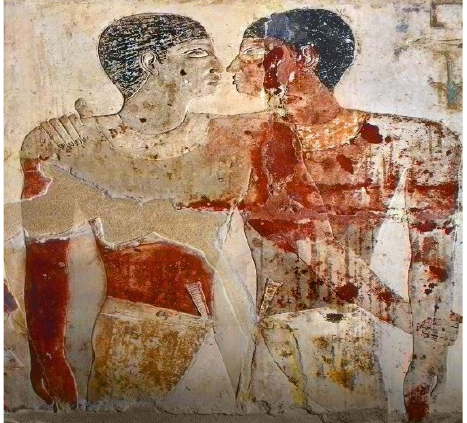
Figure 1. Dating from the Fifth Dynasty, the Nyankh-khnum and Khnum-hotep’s epigraph reads: ‘Joined in life and joined in death’. The presence of their wives and off-spring in certain panels among the glyphs has led some Egyptologists to assume they were siblings. However, repeated depictions of the two men embracing have convinced many Egyptologists that their intimate relationship might have been accepted by their respective wives. One thing is certain: the tomb depicts two men in a manner usually reserved for husband and wife, whilst there were no romantic depictions of their wives with them on the walls of the tomb itself. This argument is strengthened by the position of Khnum-hotep in many of these scenes, placing him in a position normally reserved for women, such as one scene in which he is shown smelling a lotus. Source: Public domain image via